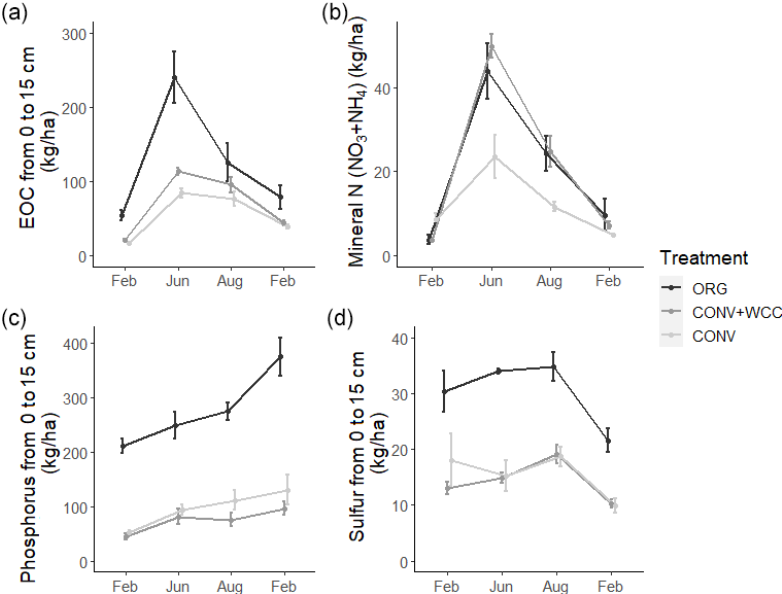
Figure A1. Extractable organic C, mineral N, phosphorus, and sulfur stocks at 0–15cm in ORG, CONV + WCC, and CONV systems over the February 2018–February 2019 season. All values are given in kilograms per hectare. Error bars represent standard